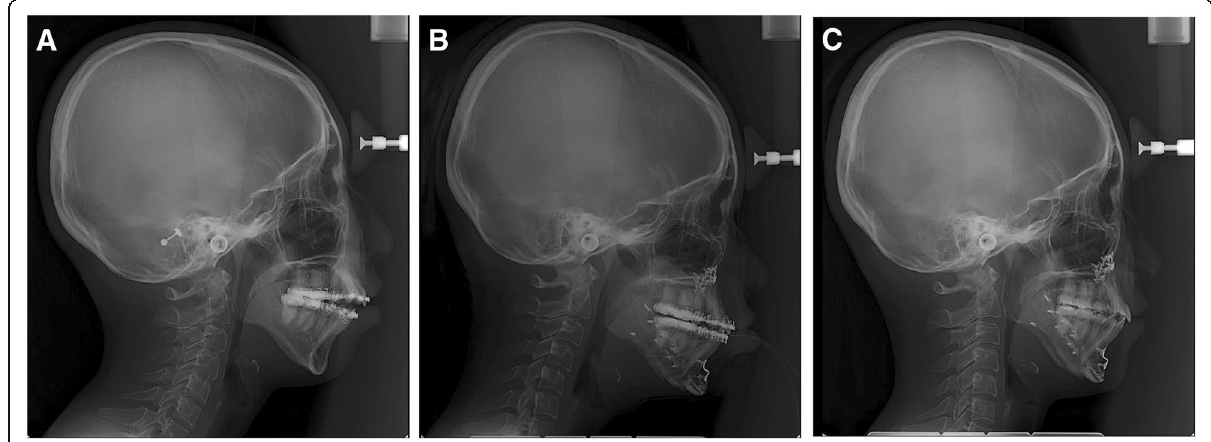
Fig. 2 Lateral cephalograms before surgery ( a ), immediately after surgery ( b ), and 15 months after surgery ( c ). In this case, BTX-A injection into the anterior belly of the digastric muscle seemed to prevent post-operative open bite. The patient ’ s overbite was successfully maintained for 15 months post-operatively. The SNB angle and mandibular plane angle were also stable